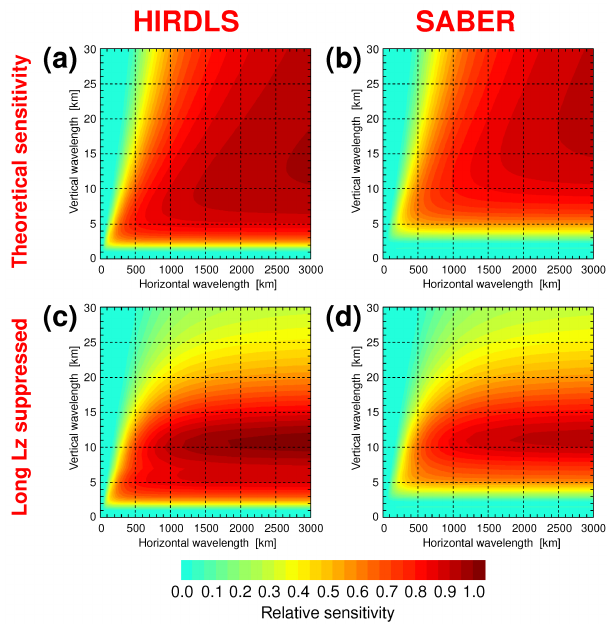
Figure 3. Sensitivity of limb sounding instruments to gravity waves as a function of horizontal and vertical wavelength. Values ap- ply for gravity wave temperature variances, squared amplitudes, potential energies, or momentum fluxes and were calculated for (a) HIRDLS and (b) SABER using the analytical approximation derived by Preusse et al. (2002) for the effects of radiative transfer and an idealized retrieval including the sensitivity reduction at short vertical wavelengths due to the vertical field of view of the instru- ments. (c) and (d) are the same as (a) and (b) , but with the additional suppression of long vertical wavelengths used for our gravity wave